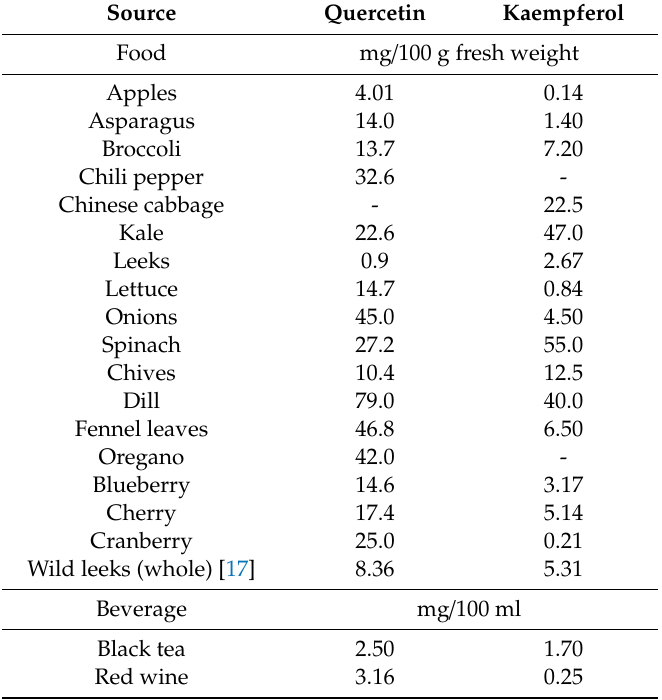
Table 1. Select Plant Sources of Quercetin and